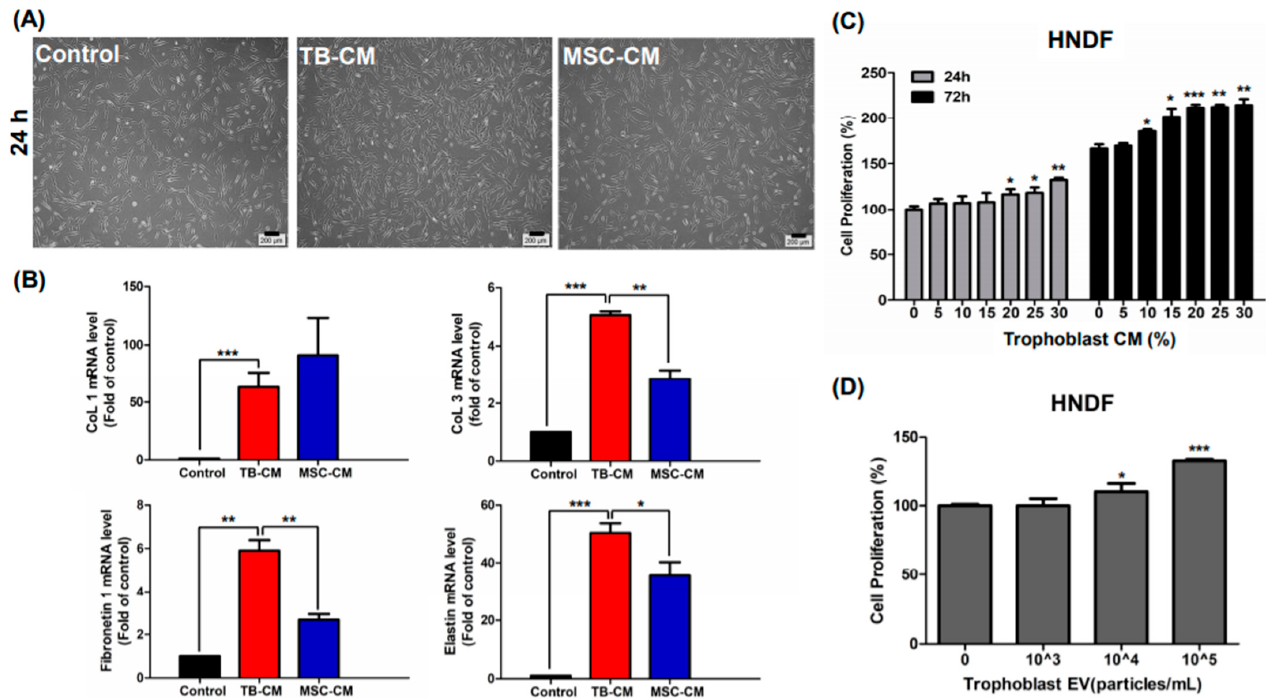
Figure 1. TB-CM and TB-Exos induced proliferation of HNDFs. ( A ) HNDFs were treated with 20% TB-CM and MSC-CM for 24 h, followed by the estimation of the number of cells under a light microscope. Scale bar: 200 µ m. ( B ) After treatment of HNDFs with 20% TB-CM and MSC-CM for 24 h, the cells were harvested and the relative mRNA levels of collagen type I and III, fibronectin 1, and elastin in the cells were quantified using quantitative RT-PCR analysis. ( C ) HNDF cells were treated with 0%, 5%, 10%, 15%, 20%, 25%, and 30% TB-CM, respectively. The cell viability was measured using CCK8 assay at 24 and 72 h. (D) HNDF cells seeded into a 96-well plate were treated with TB-Exos (1 × 10 3 , 1 × 10 4 , and 1 × 10 5 particles/mL), following which the cells were cultured in growth medium for 24 h. Cell proliferation was determined using CCK8 assay. Data are represented as means and standard deviation (n = 3); * p < 0.05, ** p < 0.01, and *** p < 0.001, as compared to the corresponding control.